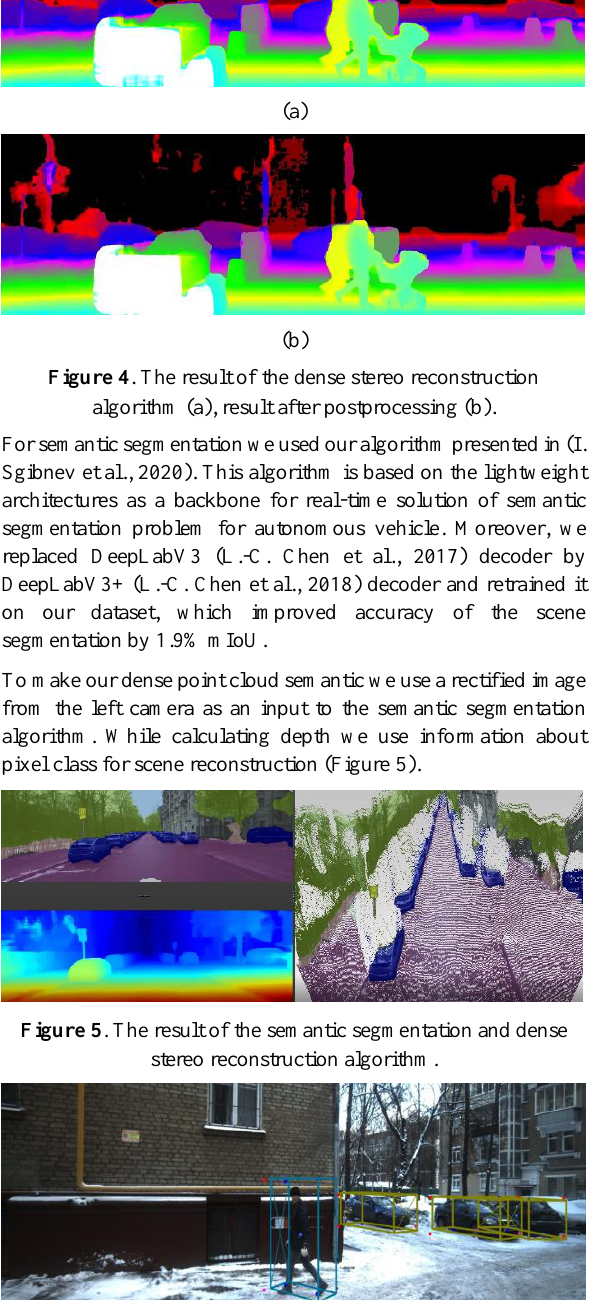
Figure 6 . The result of the 3D detection